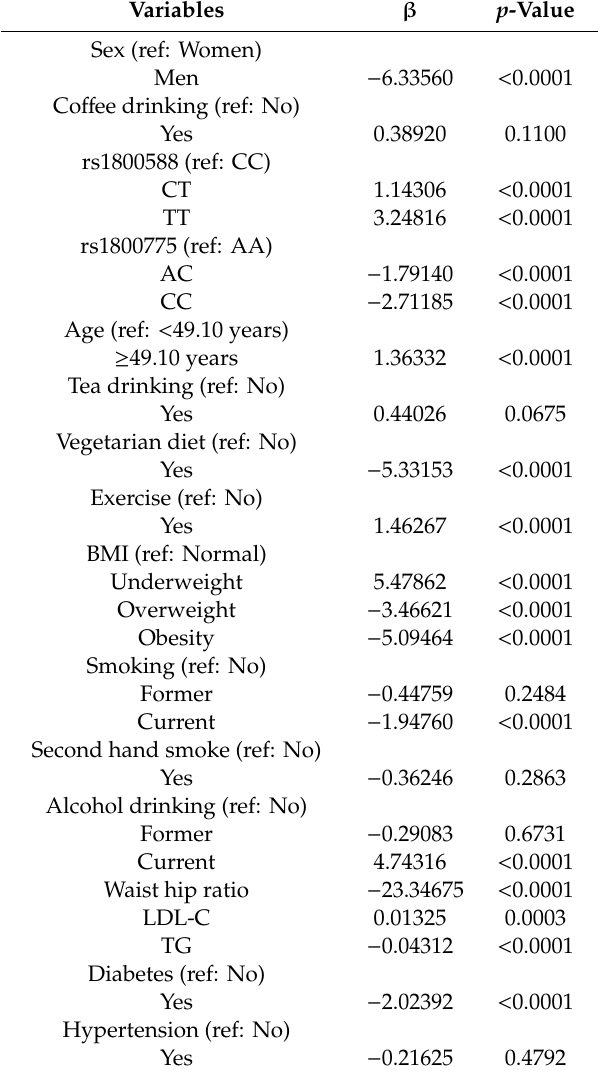
Table 2. Multiple linear regression showing the association between co ff ee drinking and high density lipoprotein cholesterol (HDL-C) in all